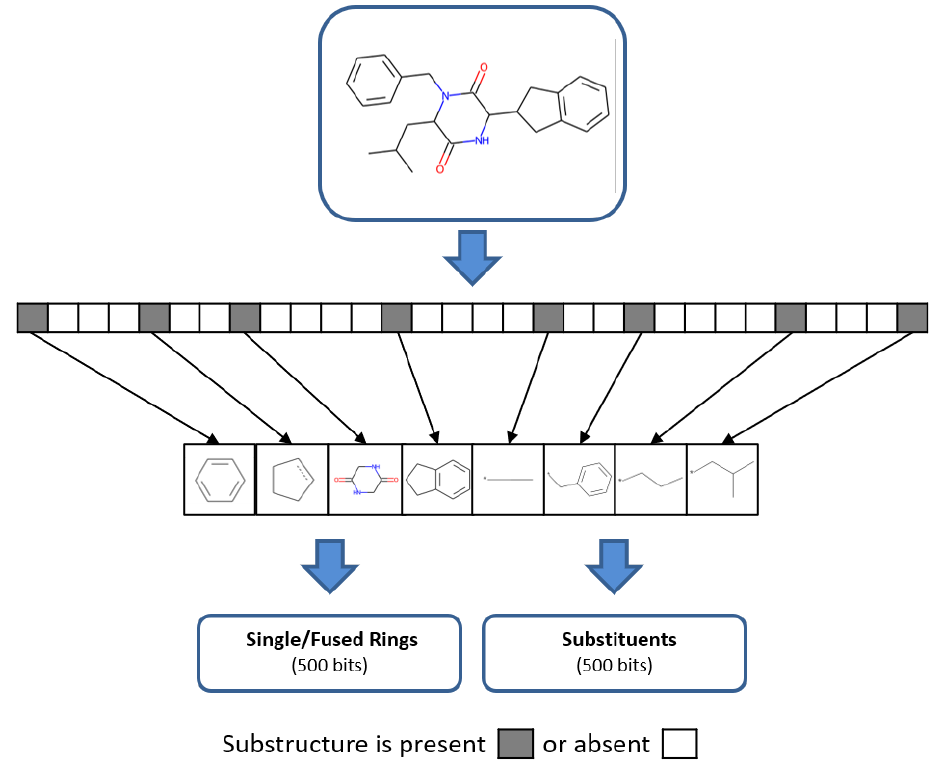
Figure 1. Keyed FP structure. The design of CSFP comprising a total of 1000 bit positions is schematically illustrated. Each bit position accounts for the presence or absence of a specific structural fragment. Ring fragments represent half of the bit positions and substituents the other half. Bit positions are set on (set to 1, gray) if the substructure is present in a molecule, or set off (white) if it is absent.